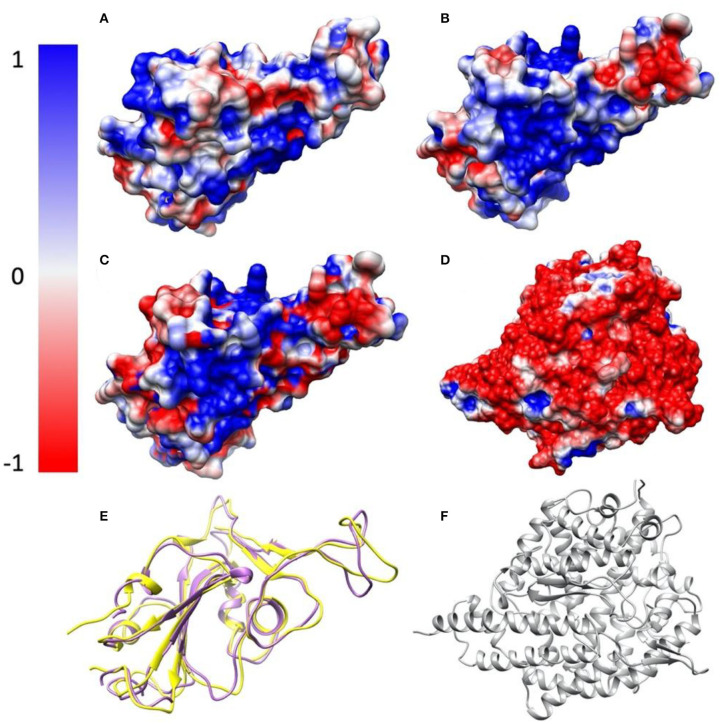
Electrostatic surfaces of SARS-CoV S protein RBD, SARS-CoV-2 S protein RBD and ACE2 RBD. (A) Electrostatic surface of SARS-CoV S protein RBD; (B) Electrostatic surface of SARS-CoV-2 S protein RBD; (C) Electrostatic difference between SARS- CoV and SARS-CoV-2 S protein RBD, by subtracting electrostatic values of SARS-CoV-2 by SARS-CoV, and mapped the values on the surface of SARS-CoV-2; (D) Electrostatic surface of human ACE2 RBD; (E) Structure comparison of SARS-CoV S protein RBD and SARS-CoV-2 S protein RBD, colored with purple and yellow, respectively; (F) The structure of human ACE2 binding domain, colored with gray.